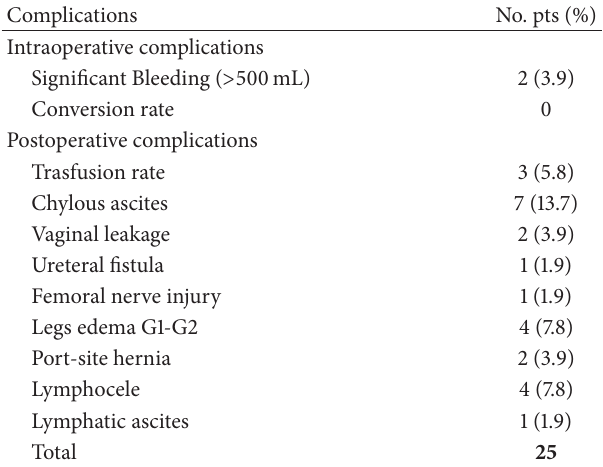
Table 4: Intraoperative and postoperative